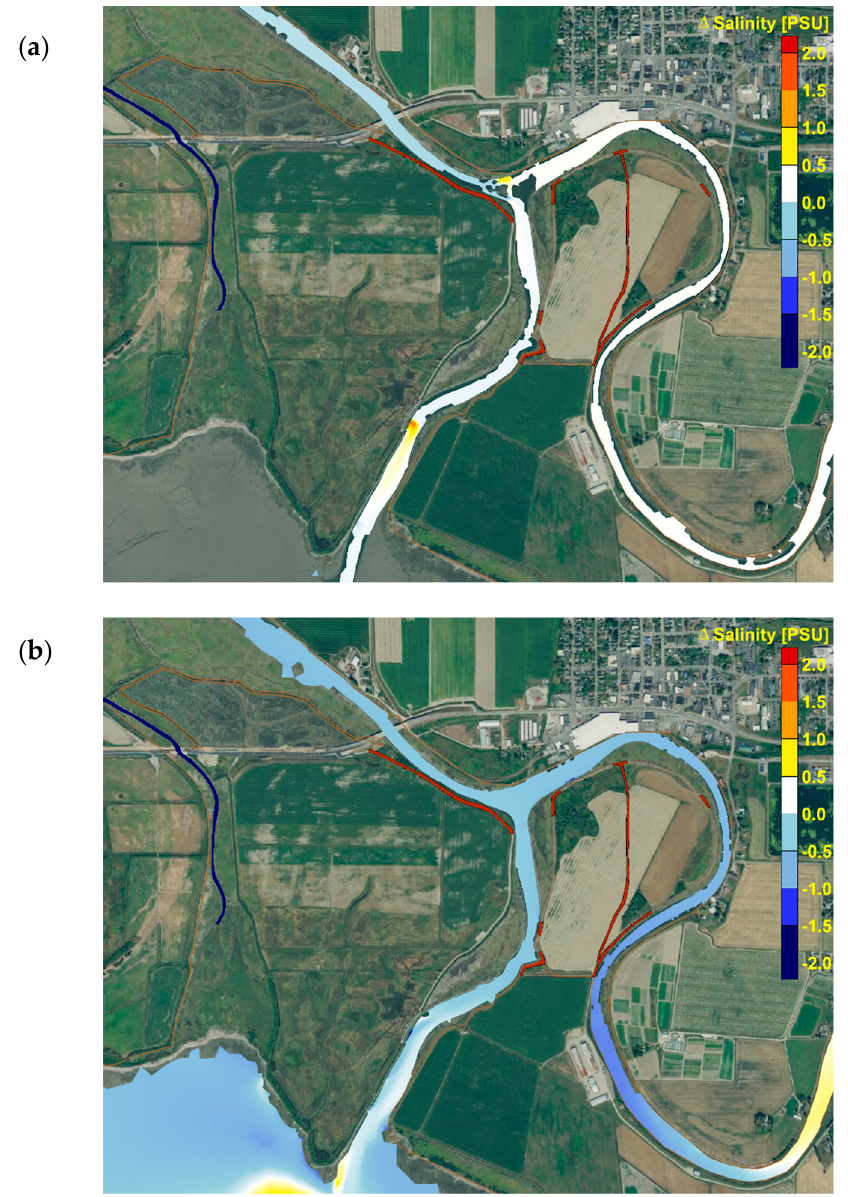
Figure 13. Salinity difference contours of the preferred restoration alternative scenario relative to the baseline at low tide (07:00: a ) and high tide (13:00: b ) on 24 October 2005.